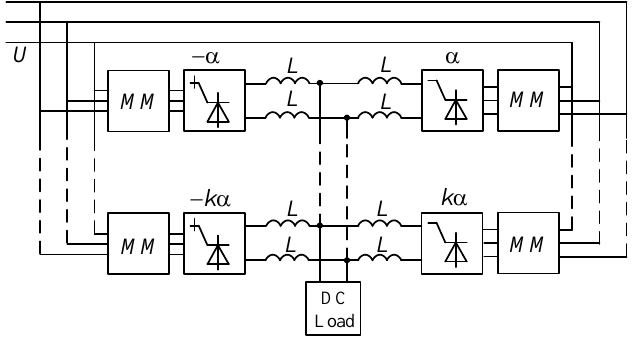
Fig. 4. Generalized functional diagram of the rectifier with electronic phase shifting. MM – matching module.